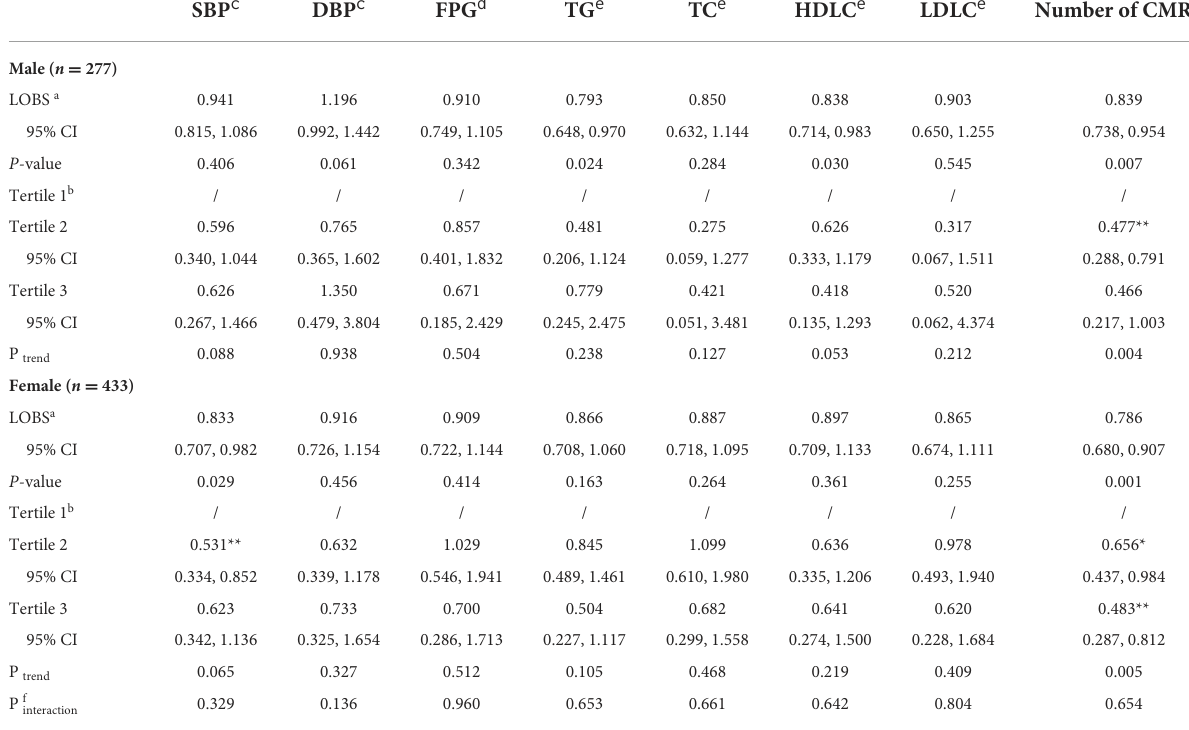
TABLE 5-2 Associations of the lifestyle-based oxidative balance score with the number of cardiometabolic risk factors and cardiometabolic biomarkers by gender using logistic